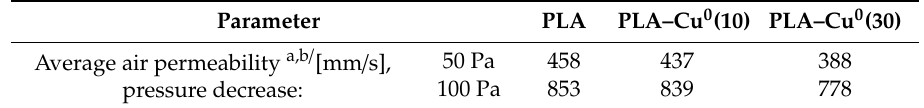
Table 6. The air flow resistance of PLA and modified PLA–Cu 0 (t) sample according to: EN ISO